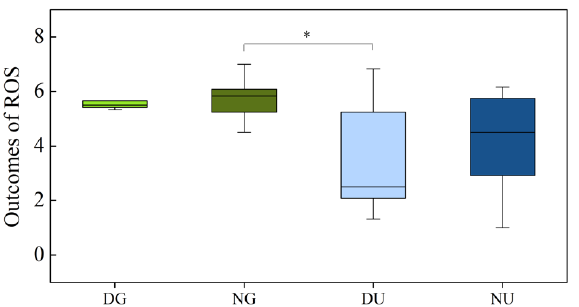
Figure 7. Restorative outcomes of Restorative Outcome Scale (ROS) in different scenarios. The DG, NG, DU, and NU represent daytime green walking, nighttime green walking, daytime urban walking, and nighttime urban walking, respectively. The * represents significant differences ( p < 0.05). Analyzed using the Kruskal–Wallis test ( N =